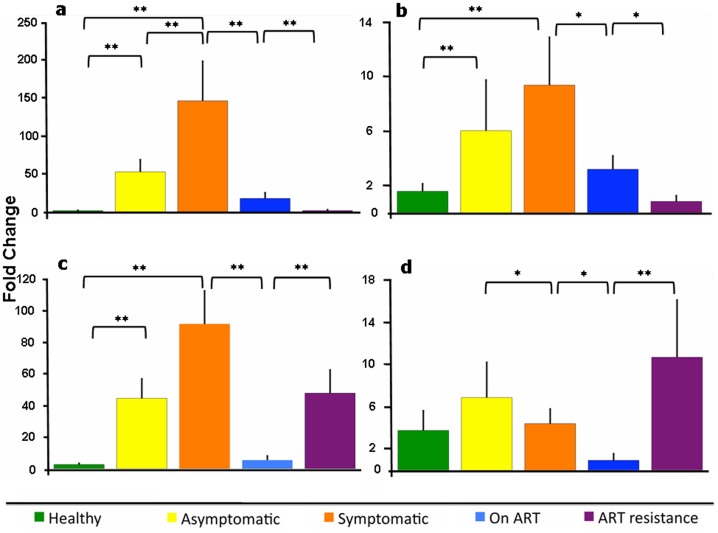
Relative plasma levels of miRNAs.The expression levels (mean ± SEM) of plasma miR-150 (a, b) and miR-146b-5p (c, d) normalized to miR-16 (a, c) and cel-miR-39 (b, d) in different groups of HIV patients and healthy controls are shown. The asterisks denote statistically significant differences (** p<0.01, * p<0.05) for the indicated groups (Student's T test).